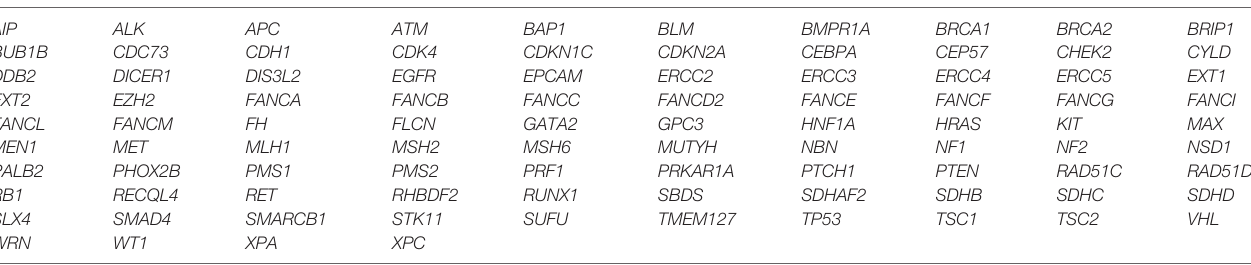
TABLE 3 | Panel of 94 predisposition genes used for NGS analysis through TruSight Cancer.